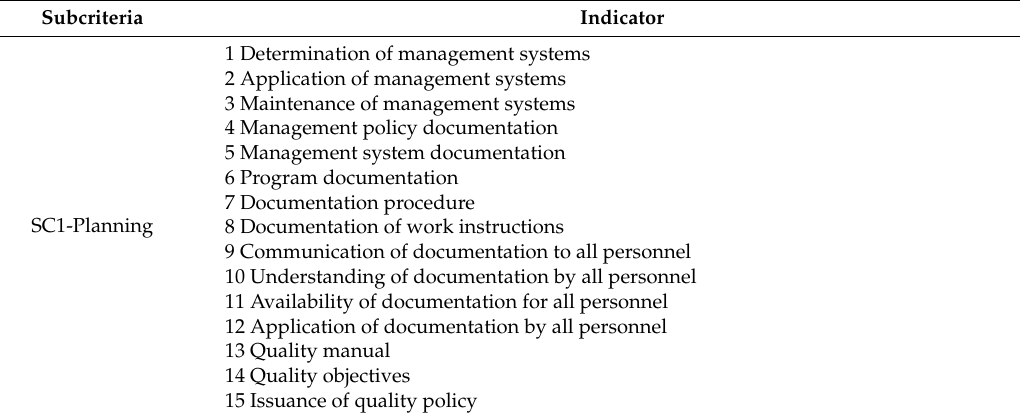
Table 2. Laboratory Readiness Measurement